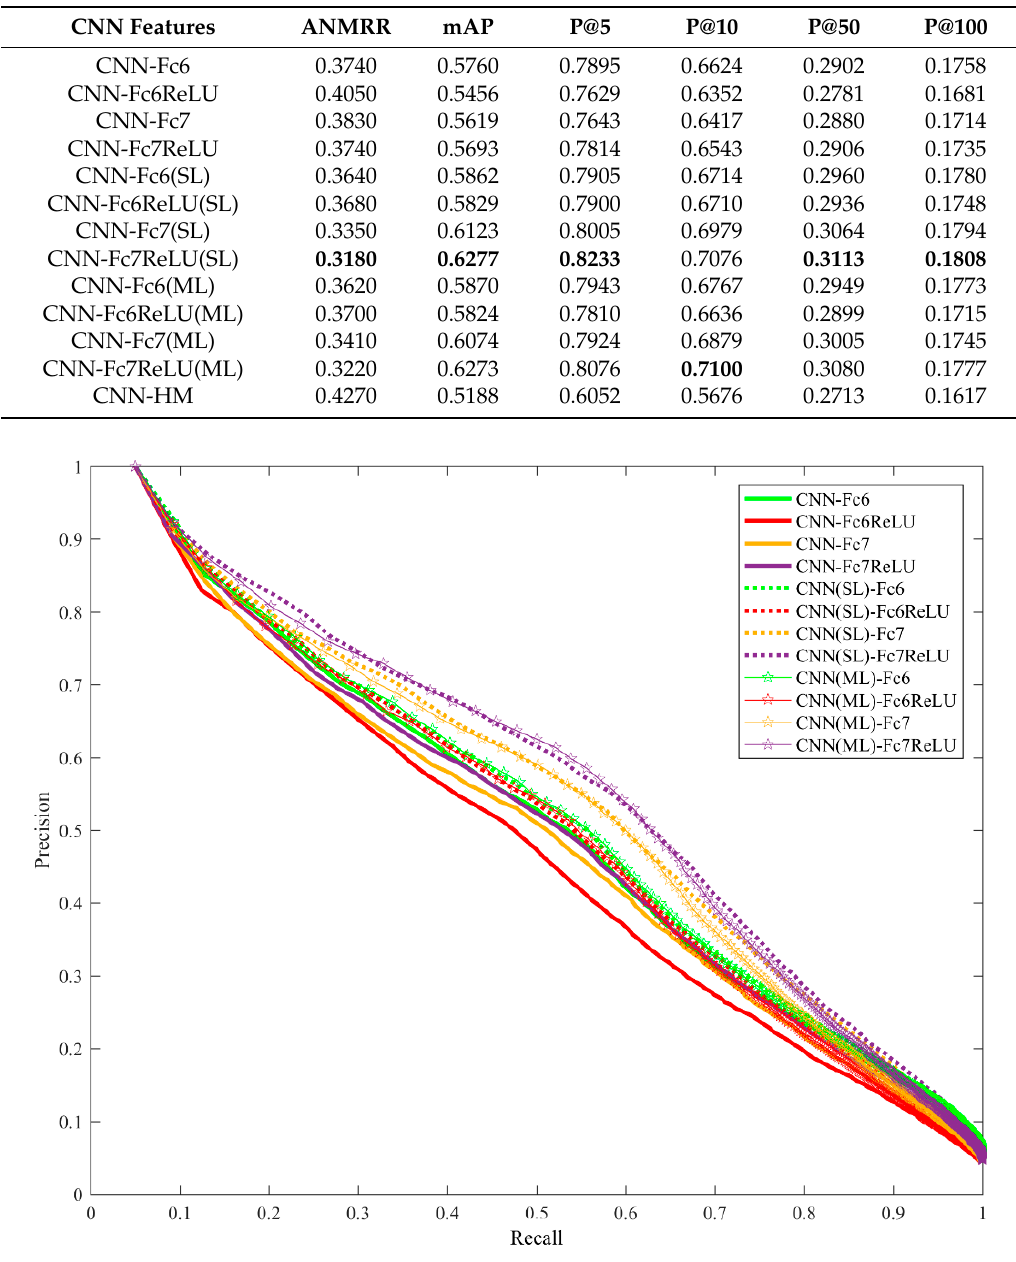
Figure 3. The precision-recall curves for single-label and multi-label RSIR.